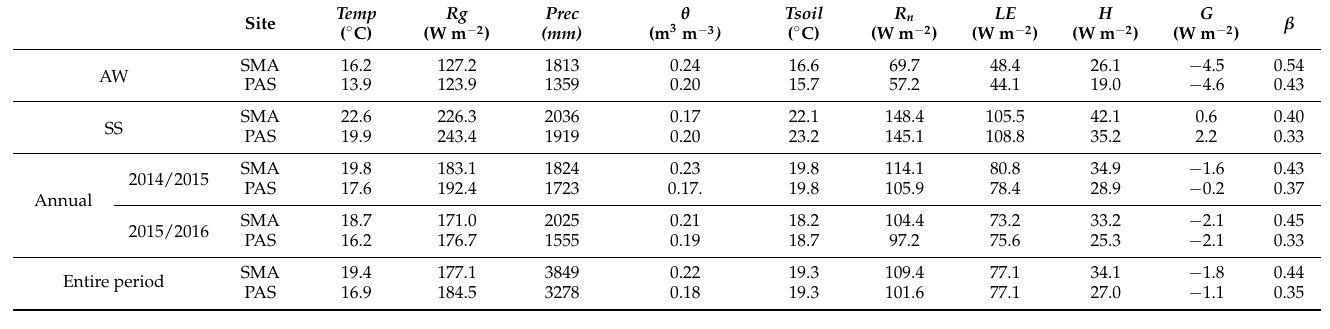
Table 2. Average of air temperature ( Temp ), solar radiation ( Rg ), accumulated precipitation (Prec ), soil humidity ( θ ), soil temperature ( Tsoil ), energy balance components ( Rn , LE , H , G ), and Bowen ratio ( β ) for the Pampa biome, at the SMA and PAS sites.